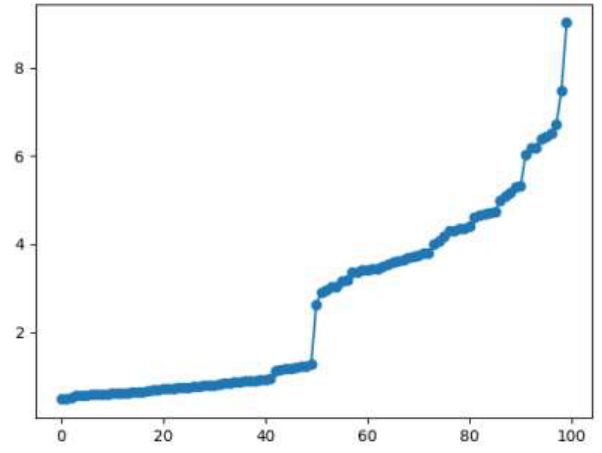
Figure 4. K-Nearest Neighbor Line Chart ( n = 100). Calculate the local density ρ i and data point distance δ j of each data point, and then draw the decision diagrams of data1 and data2 with ρ i as the abscissa and δ j as the